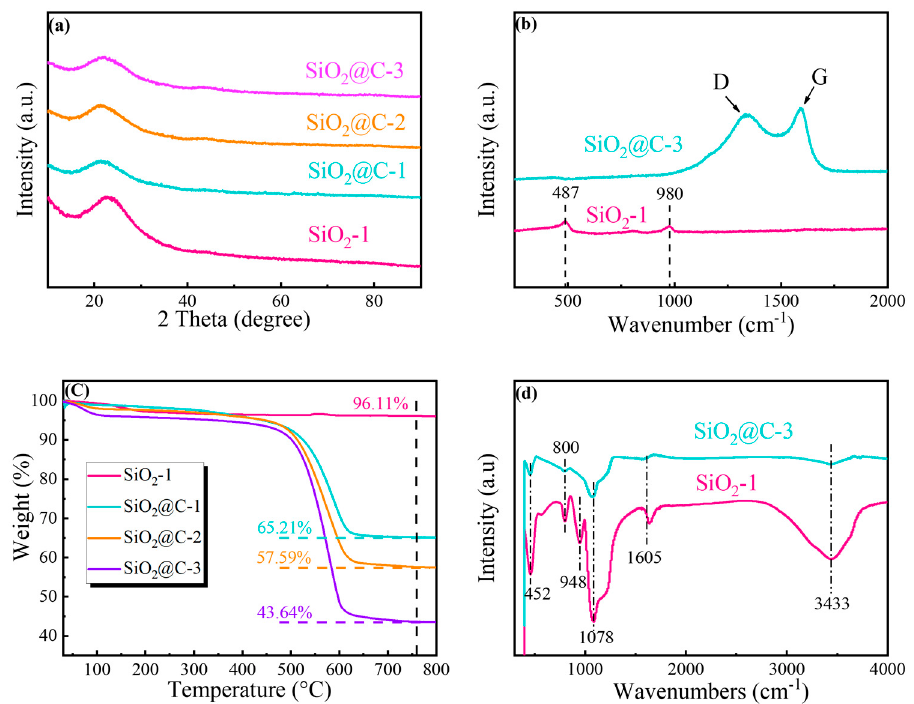
Figure 3. ( a ) XRD patterns of SiO 2 and SiO 2 @C composites, ( b ) Raman spectra of SiO 2 and SiO 2 @C − 3 composites, ( c ) TG curves of SiO 2 and SiO 2 @C composites, ( d ) FTIR spectra of SiO 2 and SiO 2 @C − 3 composites.